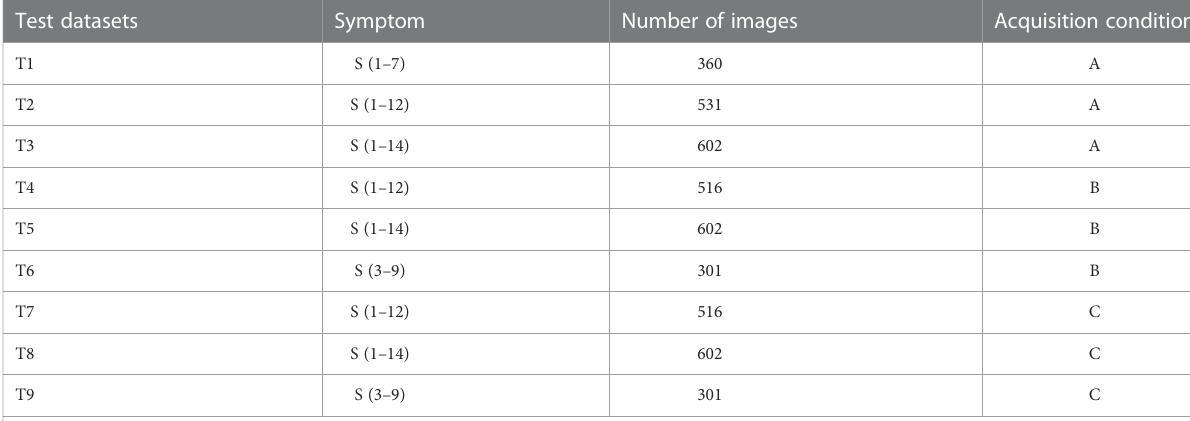
TABLE 2 Symptoms and sample sizes of test datasets acquired under different